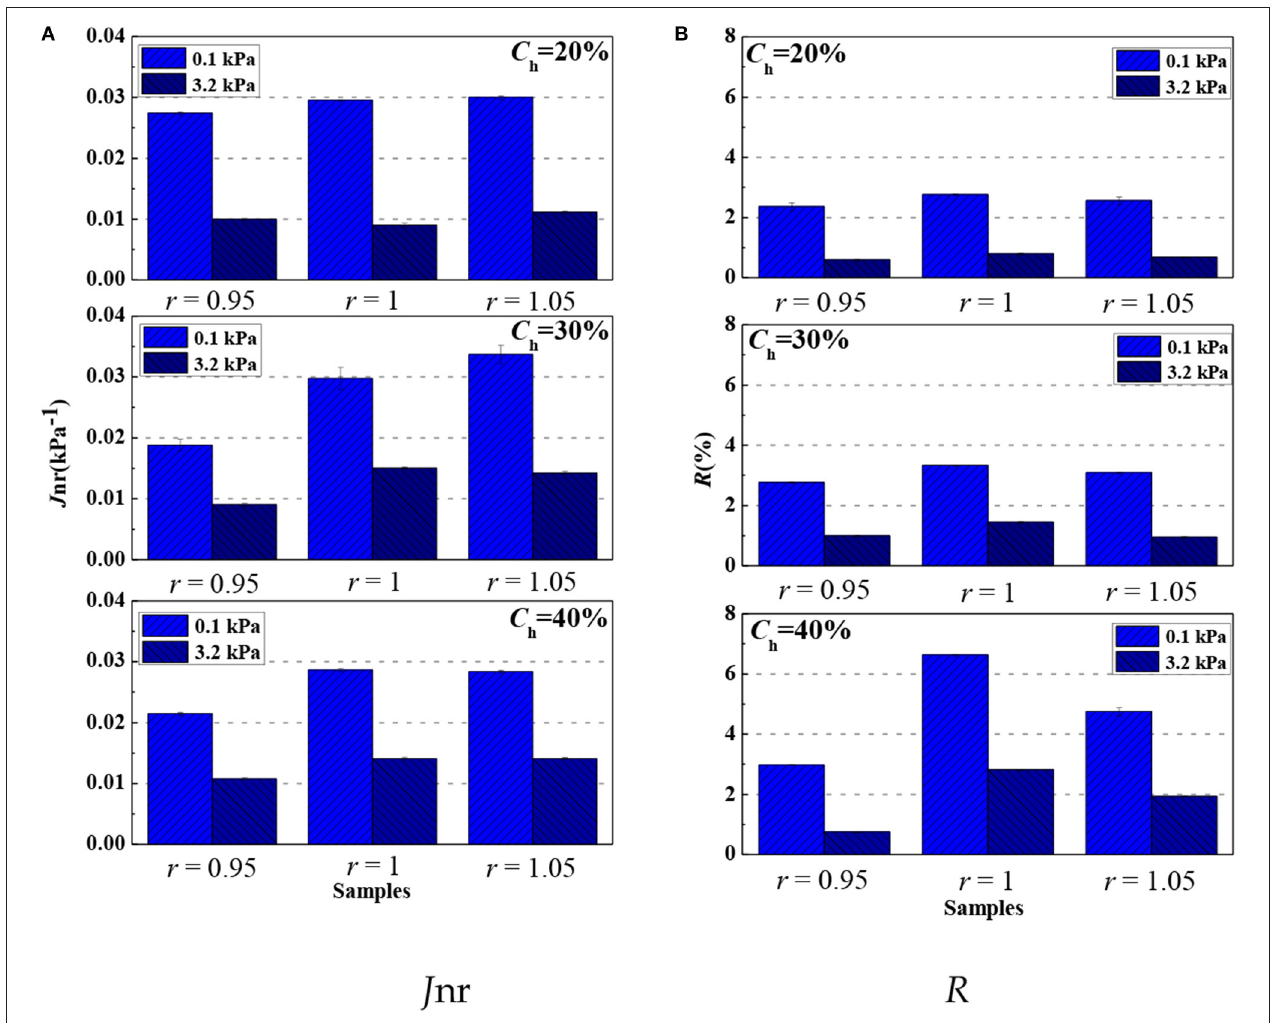
FIGURE 33 | MSCR-based evaluation of polyether-based TPU-modified asphalt. (A) J nr. (B) R